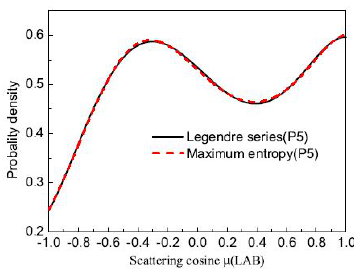
Figure 4. Exponential representation compared to the Legendre series truncated at order 5 for neutron scattering from group 90 to group 112